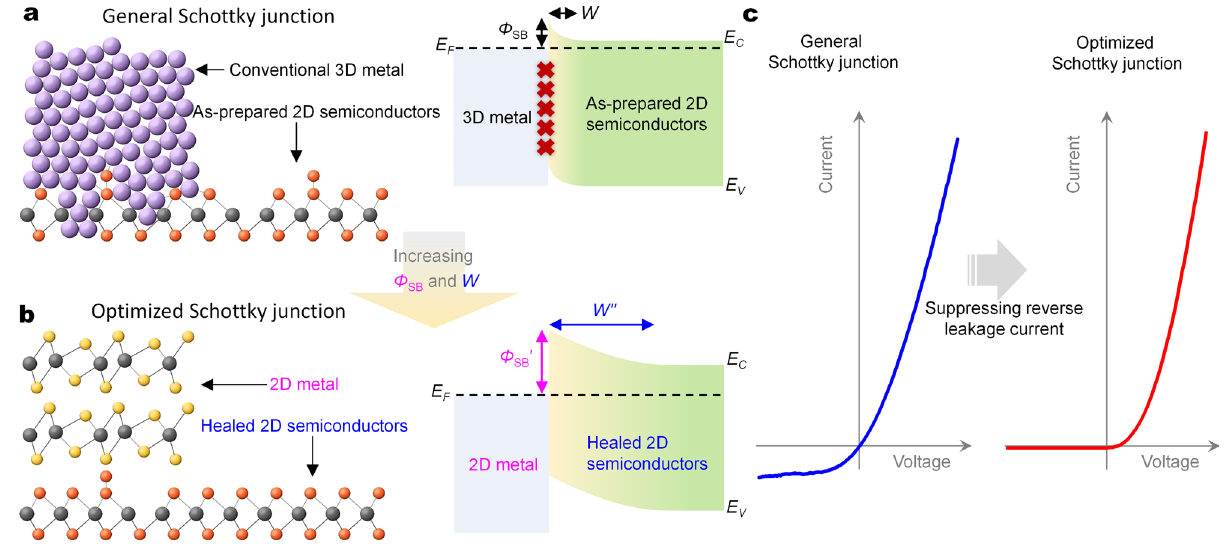
Fig. 1 Design and novelties of all 2D Schottky junctions for ideal recti fi ers. a , b Schematic diagrams of atomic structure (left) and band structure (right) of general ( a ) and optimized ( b ) Schottky junctions. The purple sphere is the element of the conventional metal electrode, and the yellow, orange, and gray spheres are the composed atoms of 2D metals and semiconductors, respectively. The red cross suggests the Fermi pinning effect. The yellow gradient areas refer to the depletion region of Schottky junction. Both the lattice defects involved by the evaporation of conventional two-dimensional (3D) metals, the decaying metallic wavefunction of conventional metals, and the interface states will cause the severe Fermi pinning effect which results in the small Schottky barrier height Φ . On the other hand, the intrinsic defect doping in as-prepared 2D semiconductors will render the high carrier concentration, SB which brings about the tiny Schottky barrier width W . The small height Φ SB and tiny width W of Schottky barrier together will lead to the large reverse leakage current of the Schottky diode. c Current – voltage curves of general (left) and optimized (right) Schottky